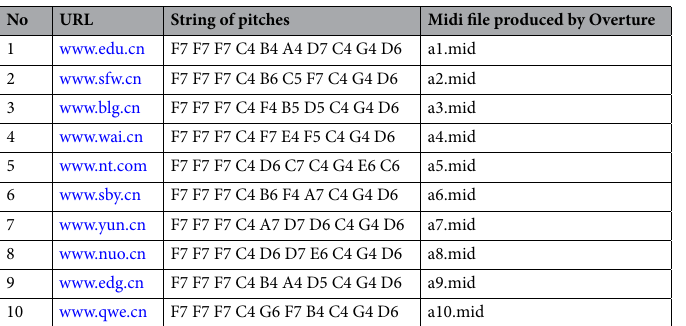
Table 2. The relationship between a URL and its string of pitches when each URL has ten characters.